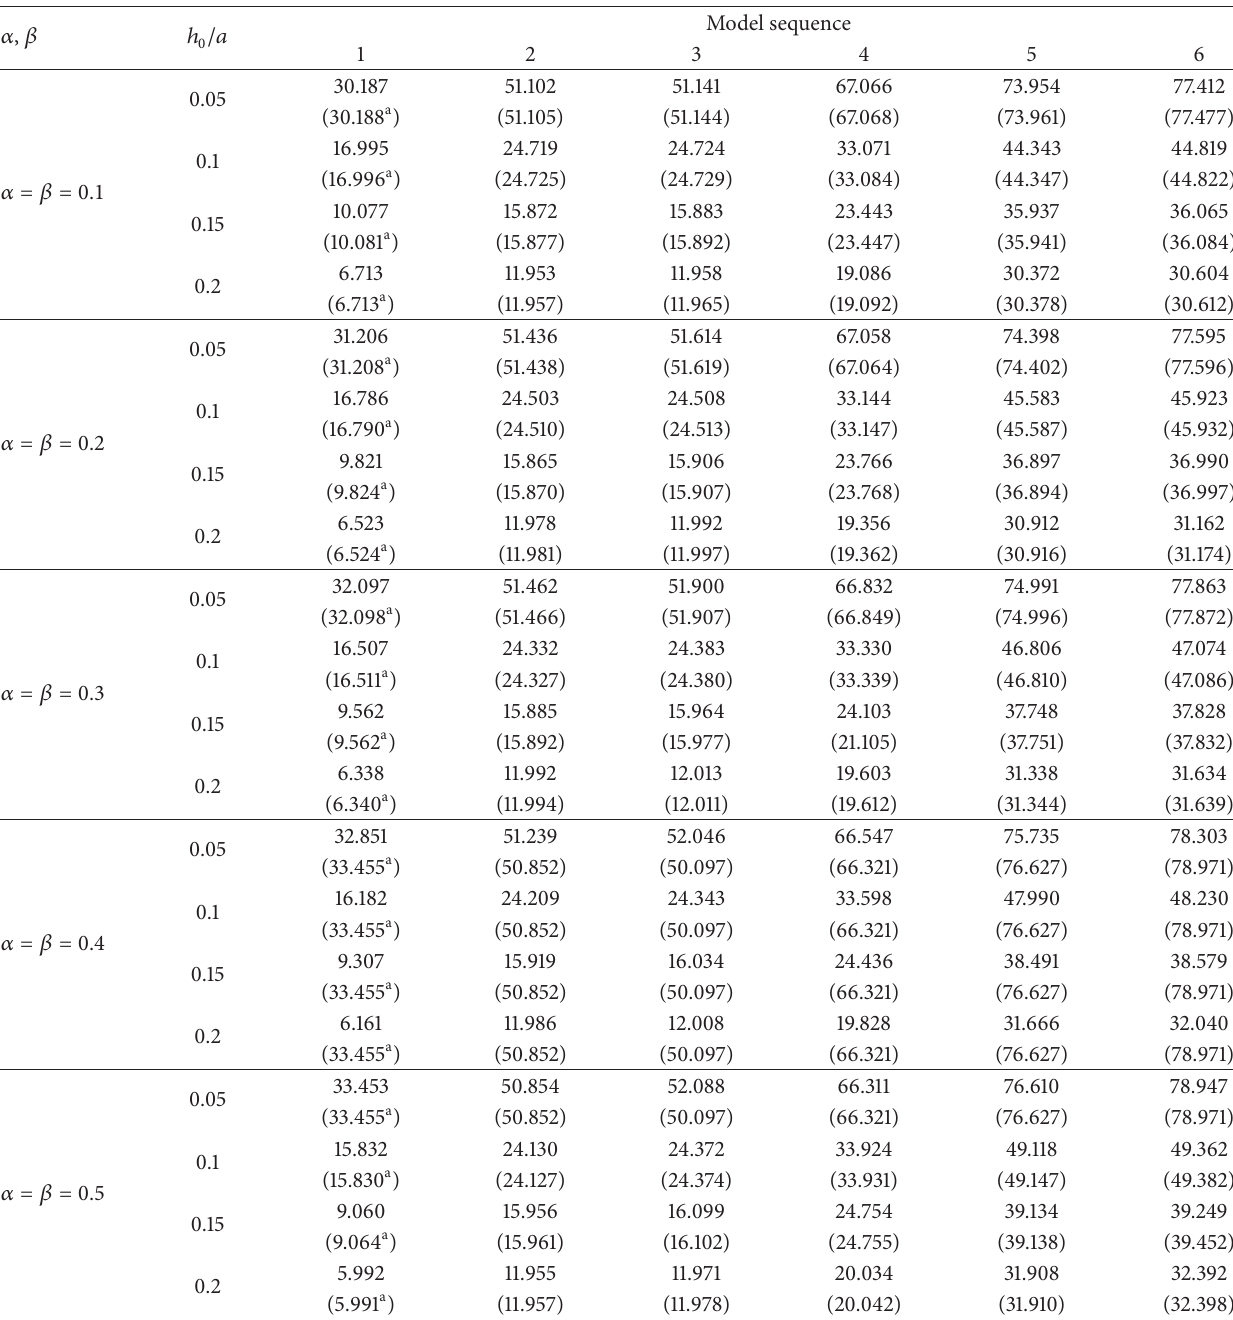
Table 12: Frequency parameter Ω = 𝜔𝑎 2 (𝜌ℎ 0 /𝐷 0 ) 1/2 for elastic support moderately thick plates ( 𝑎/𝑏 = 1 ) with different gradient ( 𝑘 𝑥0 = 𝑘 𝑥𝑎 =